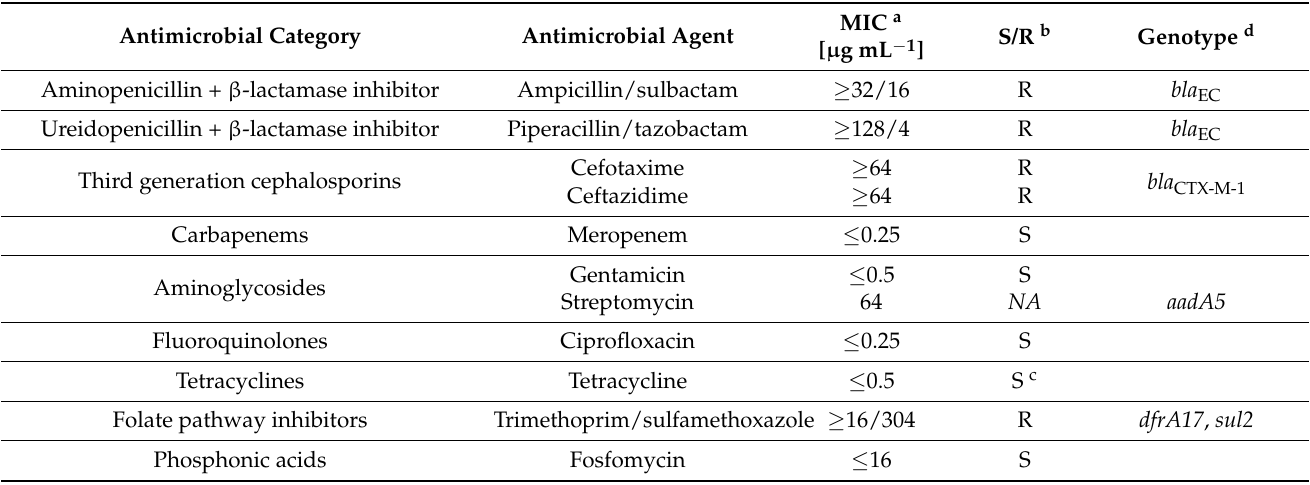
Table 1. Phenotypic and genotypic resistance profile of